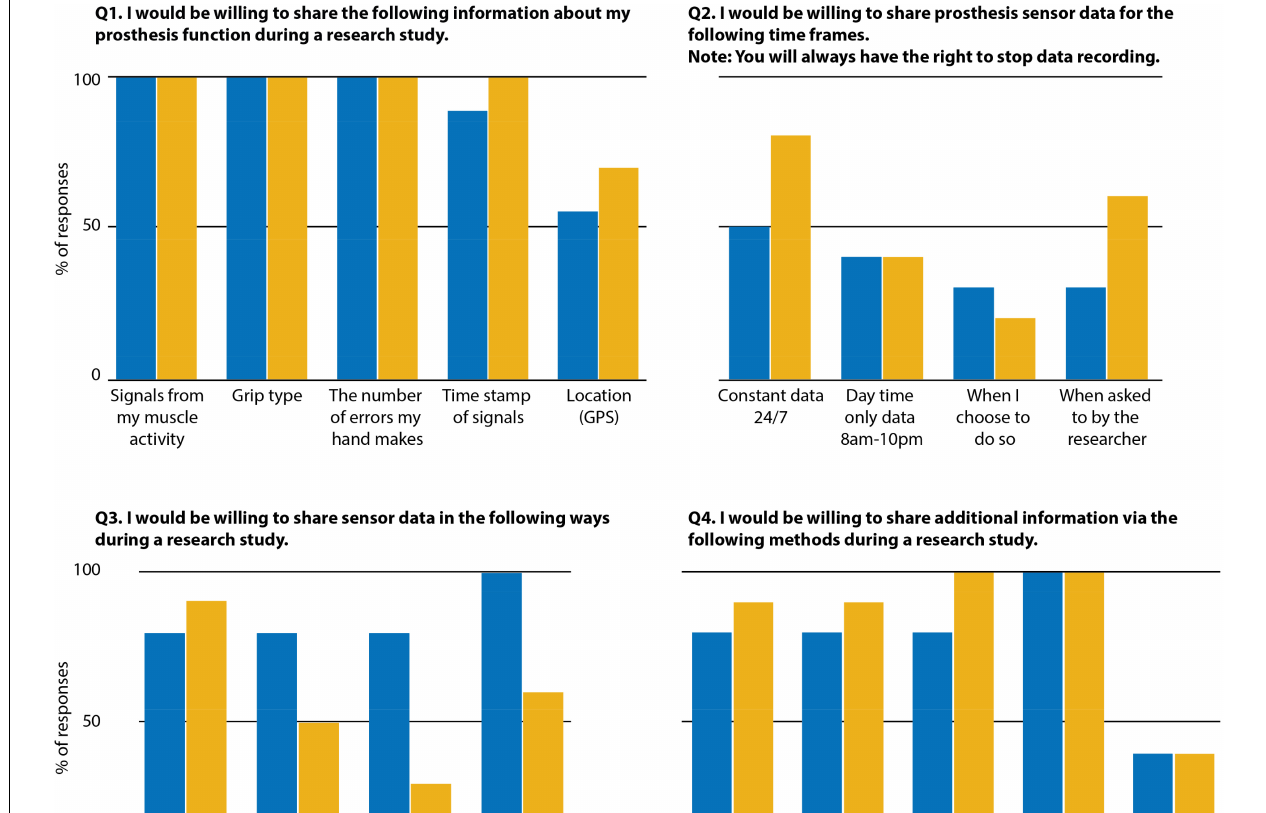
FIGURE 2 | Results of the polls completed at the beginning and the end of Workshop 2.